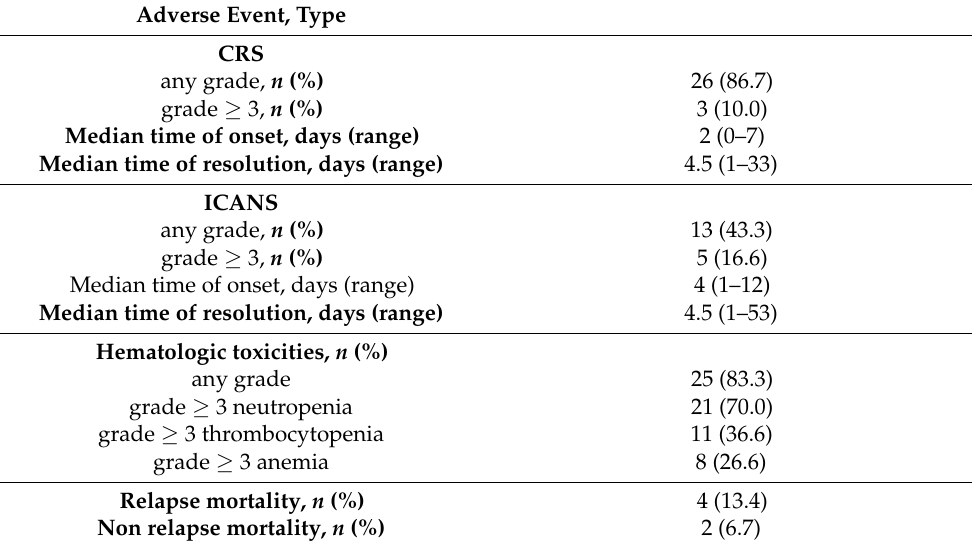
Figure 2. Median progression-free survival, disease-free survival, and overall survival of infused patients. ( A ) Median progression-free survival (PFS) of all infused patients; ( B ) Median PFS of all patients based on histology; ( C ) Median disease-free (DFS) and ( D ) overall survival (OS) of all infused patients. Table 3. The safety profile of infused